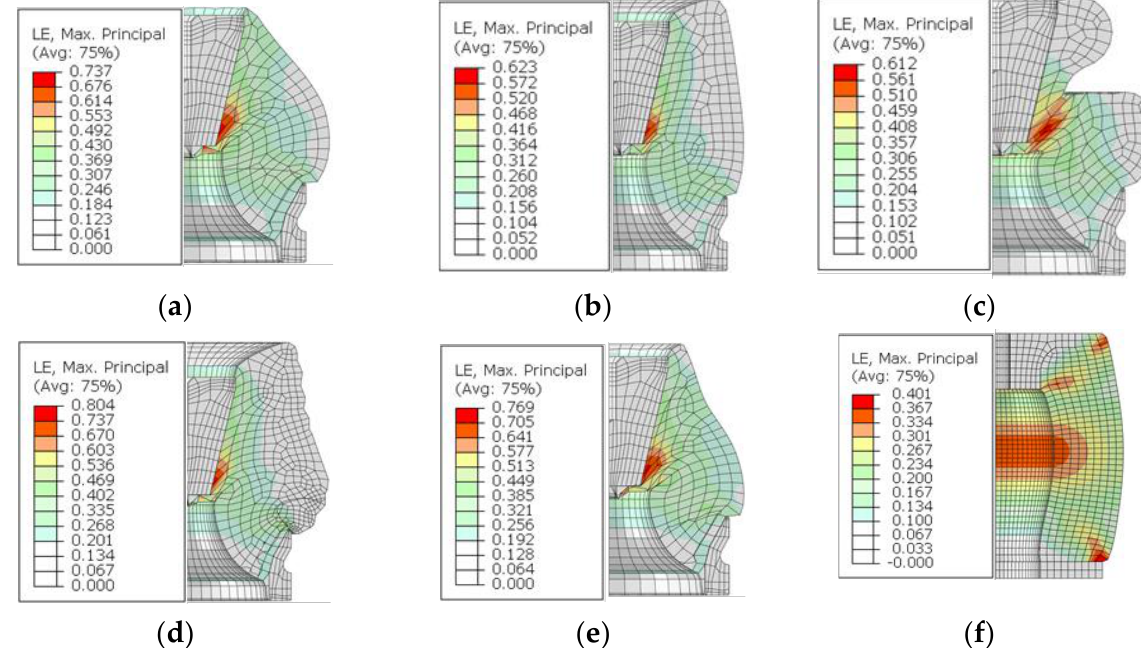
Figure 4. Concept design of the natural rubber spring under 3.4 kN compressive load: ( a ) shape 1;